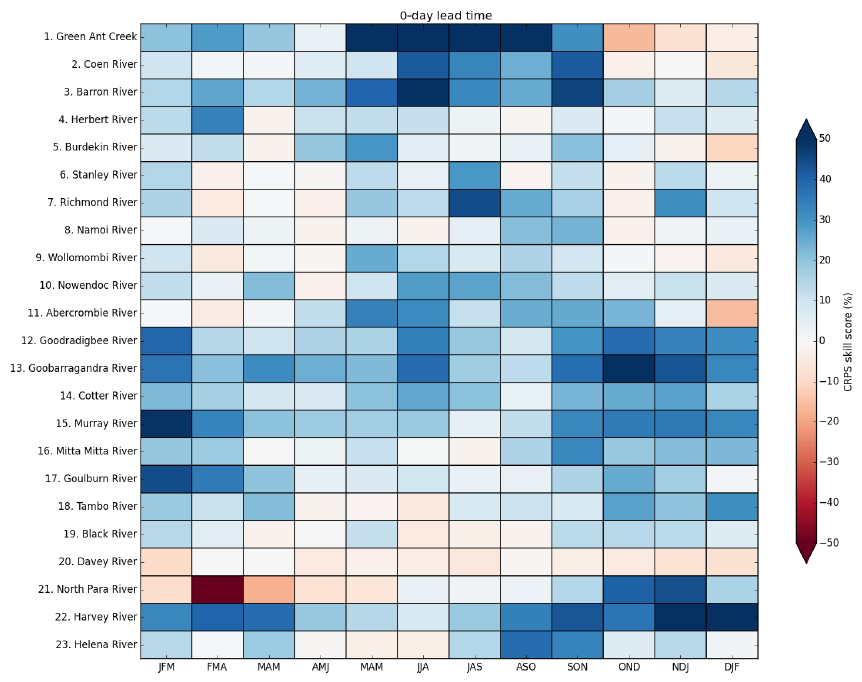
Figure 4. CRPS skill scores for each catchment and target season at 0-day lead time. Skill scores are relative to climatology. Leave-five- years-out cross-validation is applied for the period 1982–2011.